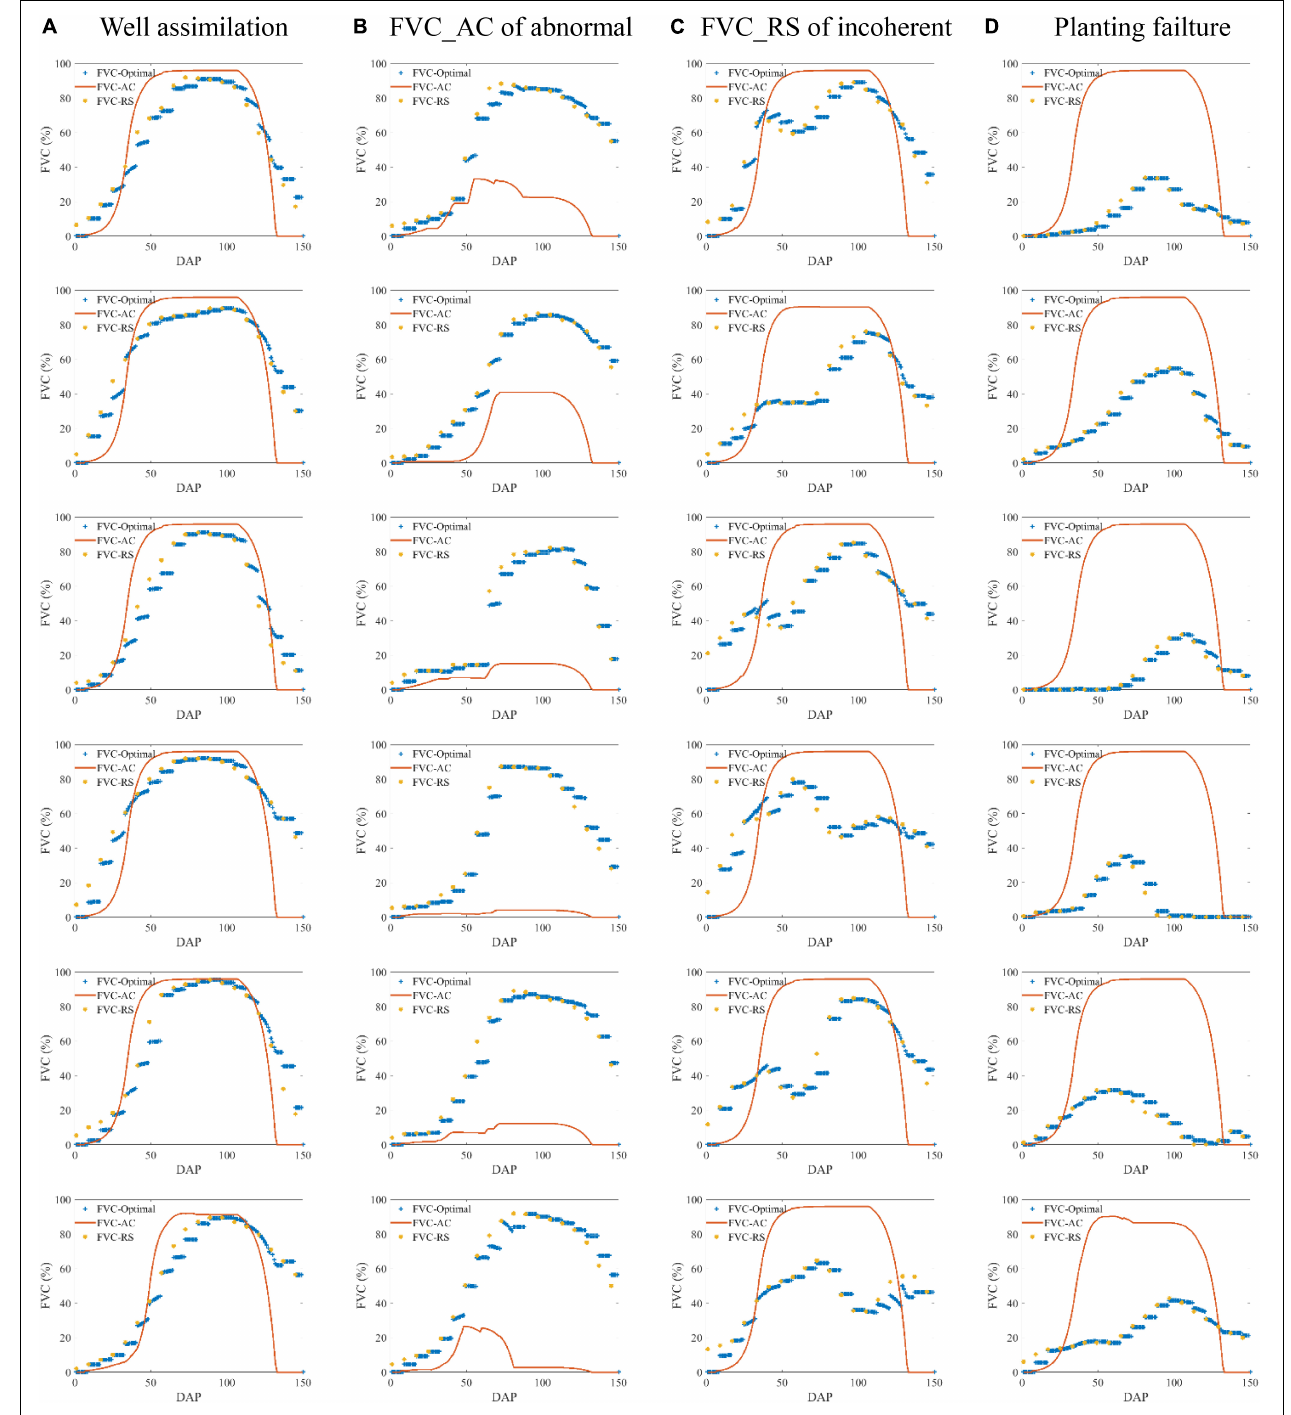
FIGURE 8 | Several examples of FVC assimilation based on the EnKF multithreaded algorithm.